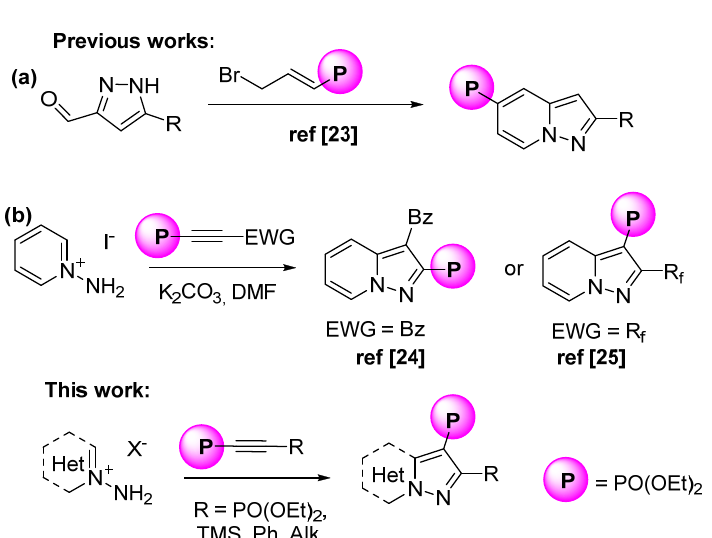
Figure 1. Biologically active derivatives of pyrazolo[1,5- a ]pyridine.